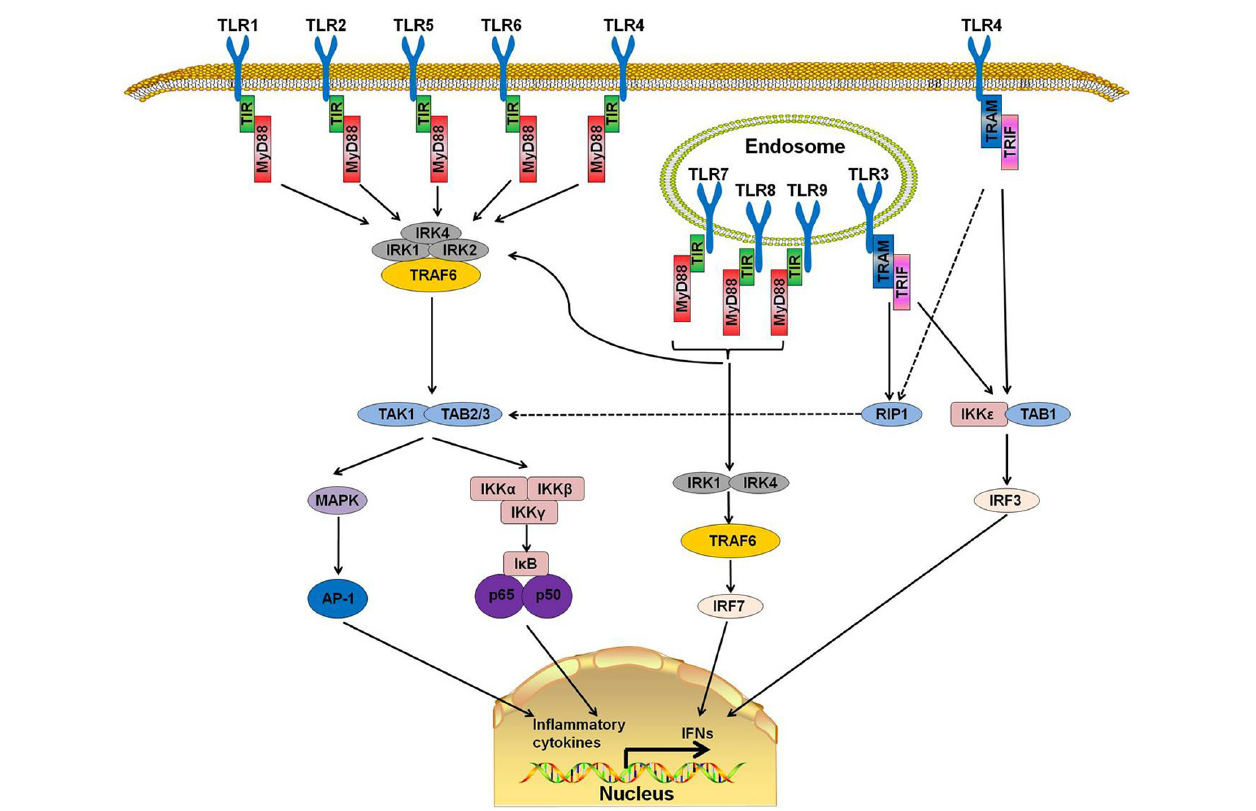
FIGURE 1 | Toll-like receptor (TLR) signaling pathways. TLR 1, 2, 4, 5, and 6 are located on the cell surfaces. When stimulated by pathogen-associated molecular patterns (PAMPs), myeloid differentiation primary response protein 88 (MyD88) interacts with IL-1 receptor-associated kinase-4 (IRAK-4) and forms